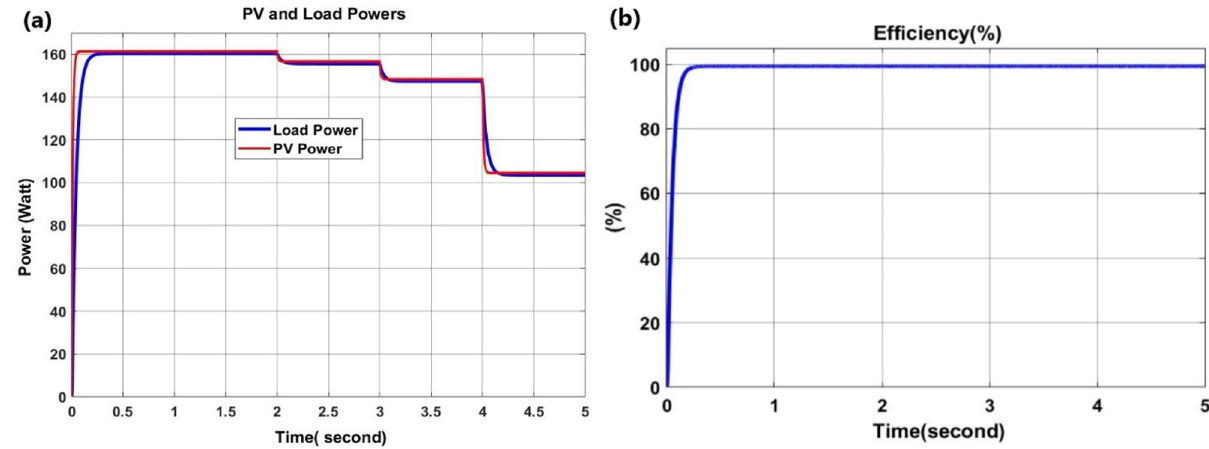
Figure 9. PV and battery (load) powers ( a ) and efficient of 99.99% at standard test conditions ( b